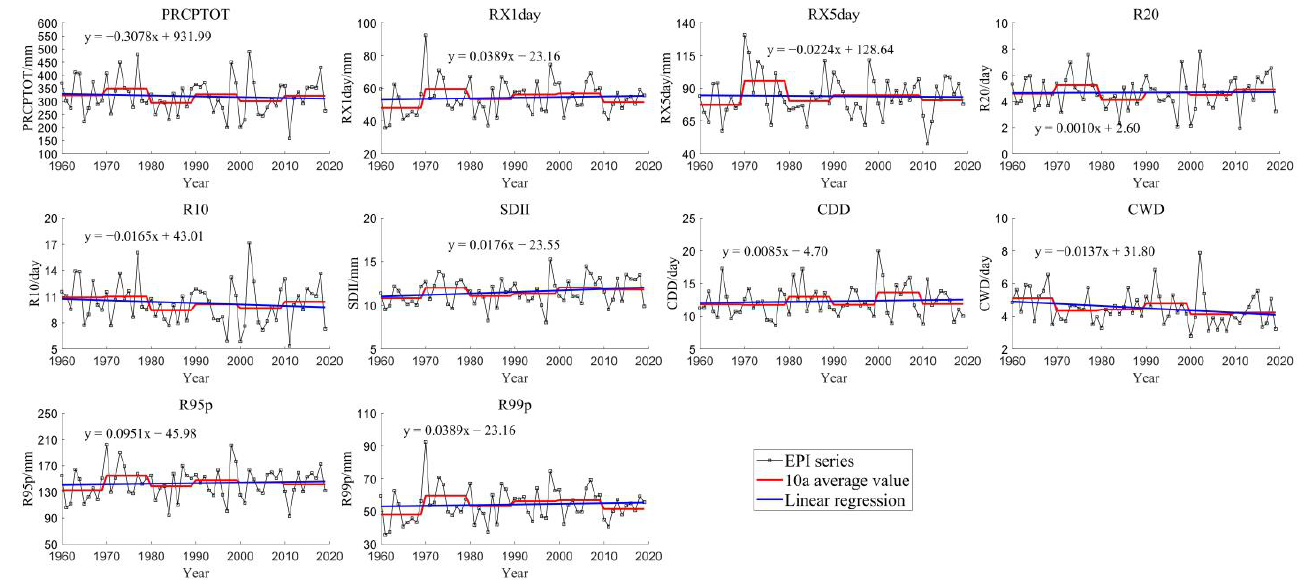
Figure 5. Trend and 10a average value of EPIs within Hubei province in spring during 1960 – 2019. Table 4. Statistic of change trend of each EPI within Hubei province in spring during